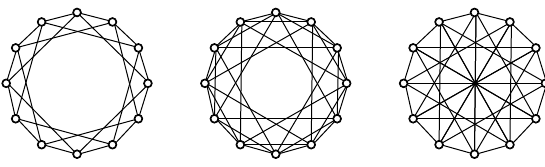
Figure 3: The circulant graphs C 12 (1, 3) , C 12 (1, 2, 4) and C 12 (1, 4, 6) .